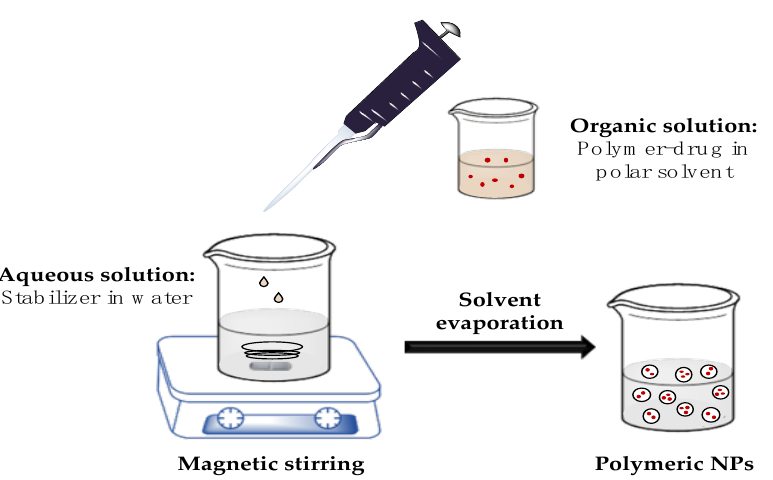
Figure 2. Schematic representation of nanoprecipitation method. Table 1. Formulations for blank and drug-loaded nanoparticles preparation.